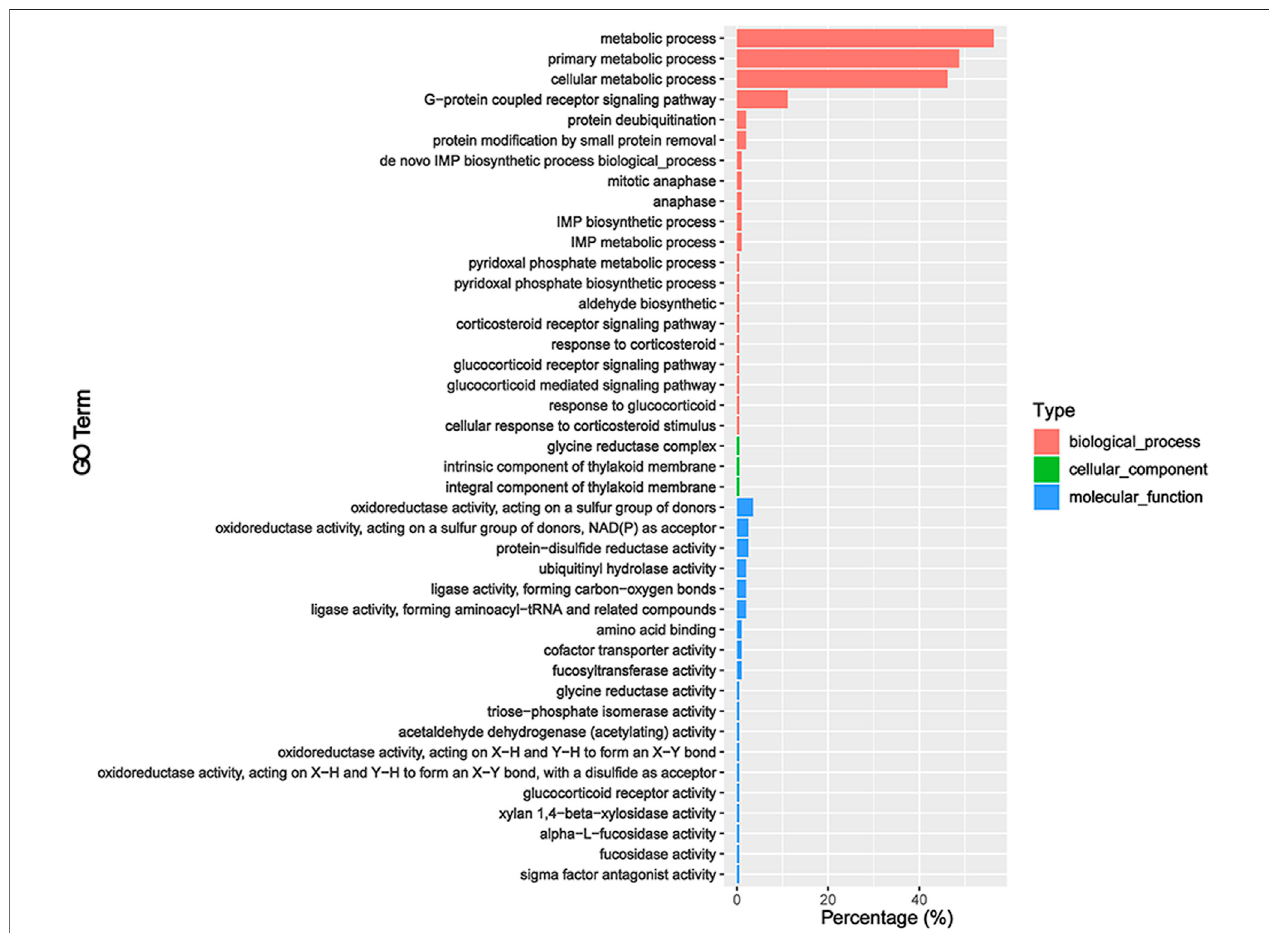
FIGURE 4 | GO annotation of the predicted target genes of sex-biased differentially expressed miRNAs (ovaries relative to testes) in summer.